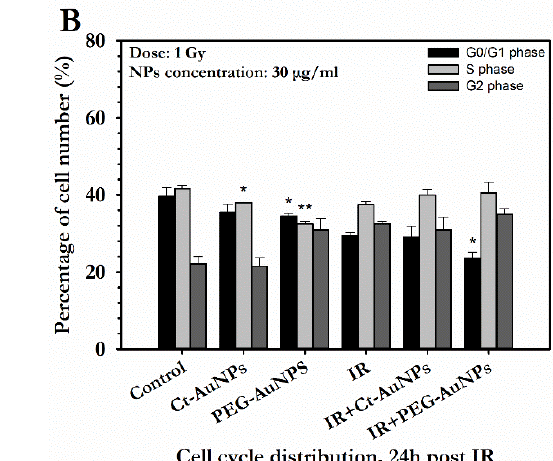
Figure 11. Flow cytometry analysis of cell cycle phase distribution of A549 cells in dependence of the irradiation and AuNP treatment (30 μ g/mL). ( A ) Cell cycle distribution 3 h after 1 Gy of IR exposure. Cells were treated with AuNPs for 24 h, irradiated and collected 3 h after exposure. ( B ) Cell cycle distribution 24 h after 1 Gy of IR exposure. Cells were treated with AuNPs for 24 h, irra- diated and collected 24 h after exposure. Statistical significance was determined using Student t test: * p ≤ 0.05. Non-irradiated groups with AuNPs were compared with the control group to evaluate statistical significance whereas irradiated groups with AuNPs were compared with the radiation alone group.